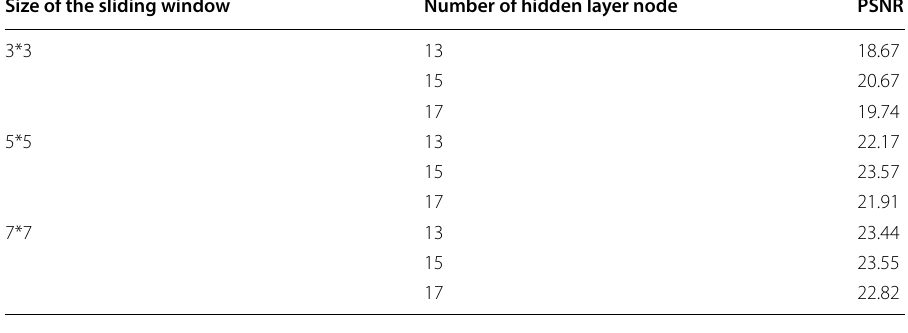
Table 4 Performance of BP neural network with different number of hidden layer nodes Size of the sliding window